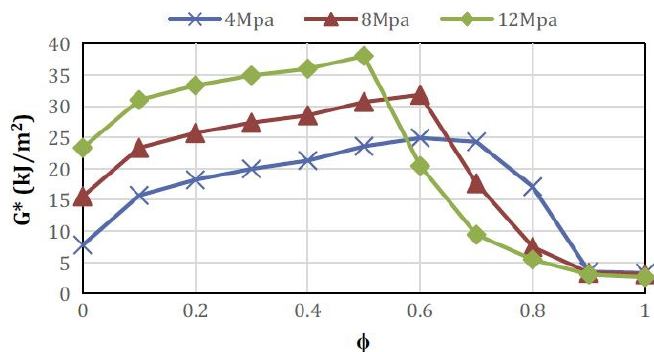
Figure 30. E ff ect of residual thermal stress on apparent fracture toughness of the z-Pinned laminate [29].